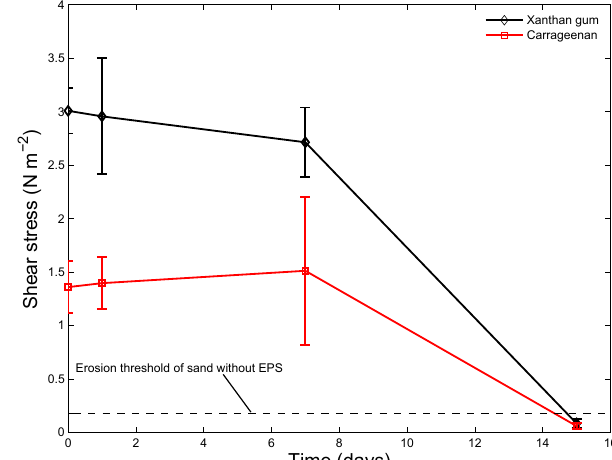
Figure 6. The threshold for erosion as a function of time for xan- than gum and carrageenan as measured with the CSM erosion de- vice. Error bars are standard deviations from n = 3 repeat measure- ments.